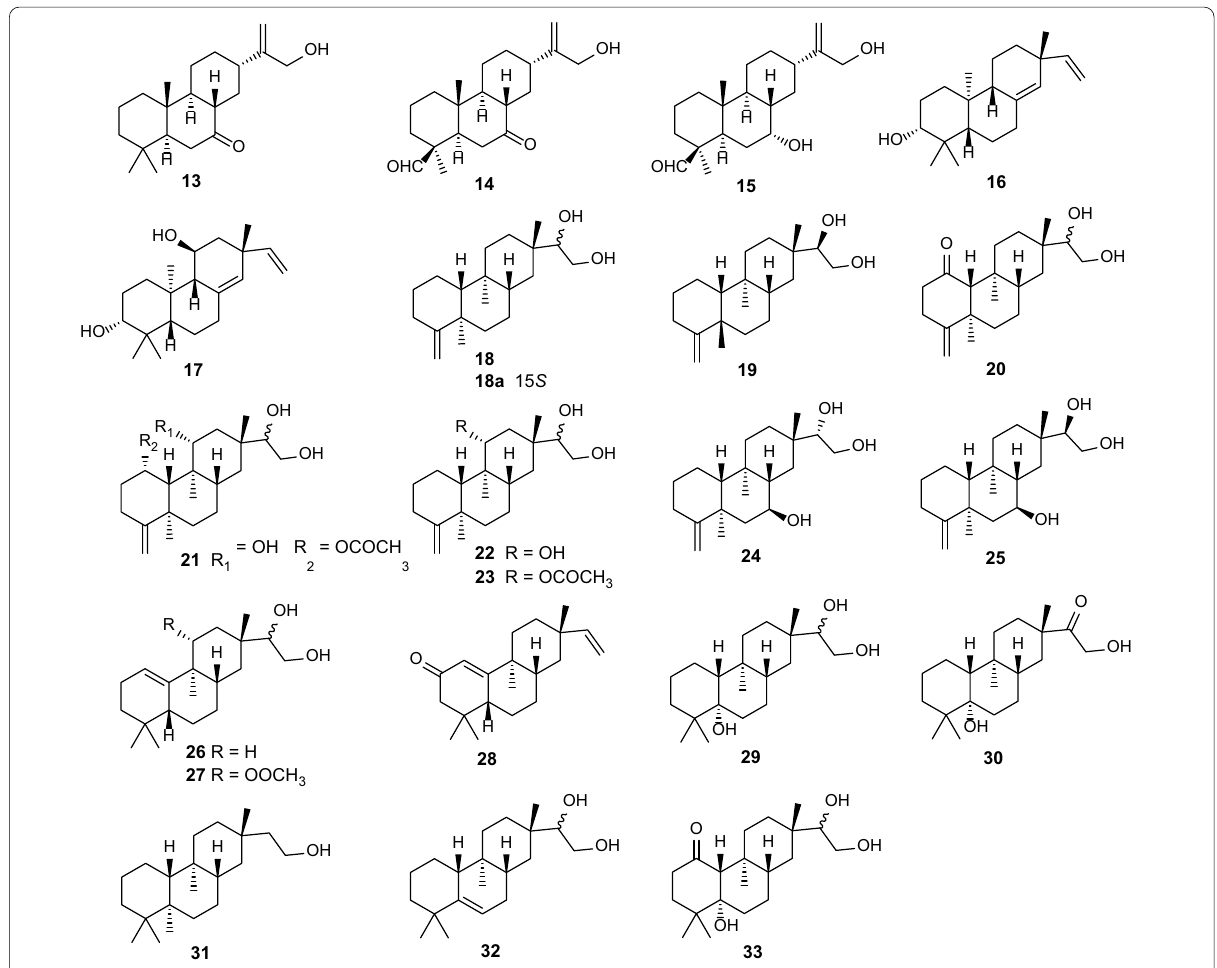
Fig. 3 Chemical structures of tricyclic diterpenes ( 13–33 ) found in Erythroxylum